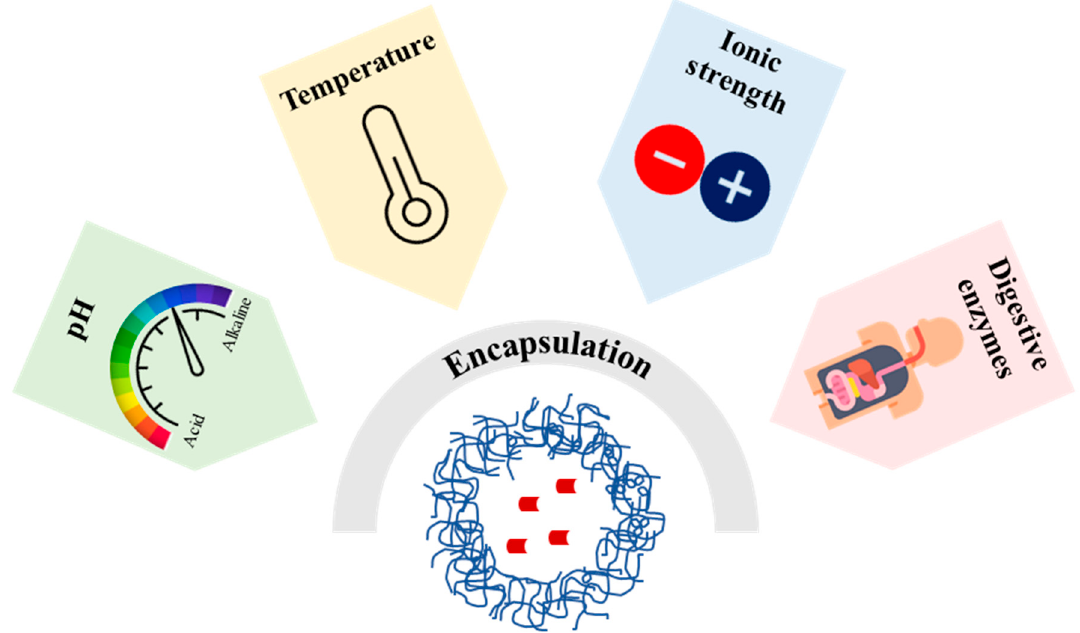
Figure 5. Environmental stimuli that affect encapsulation stability.